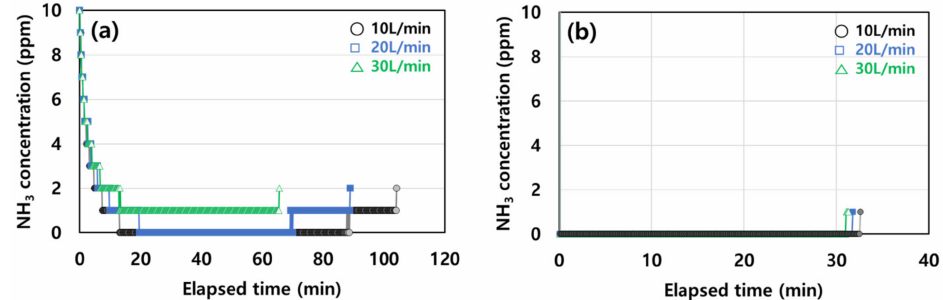
Figure 5. Effect of flow rate under different NH 3 feed concentrations at ( a ) 40 ppm and ( b ) 1000 ppm on the adsorption performance of activated